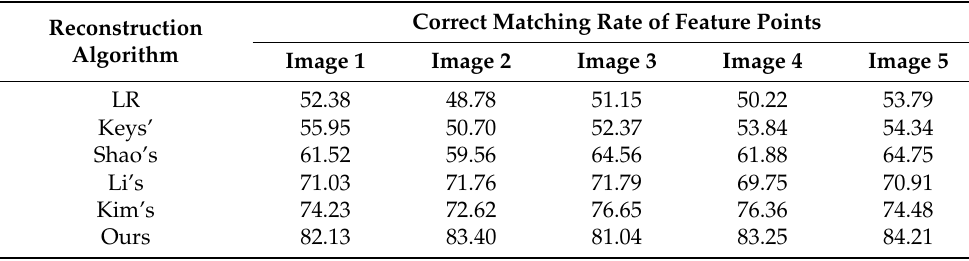
Table 4. The correct matching rate of feature points in images reconstructed by different